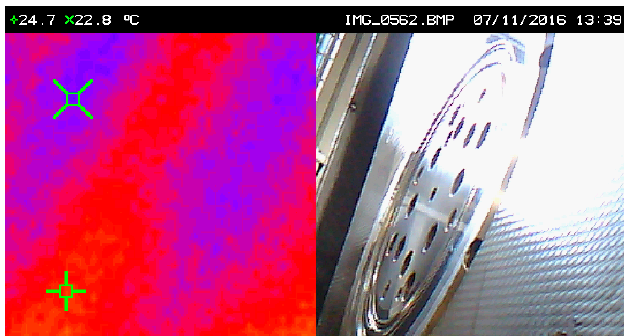
Figure 16. Temperature developed in the TiAlN-coated pressure ring obtained by thermography. In the ( left ) image, the thermograph image corresponding to the tool surface shown in the picture ( right ).